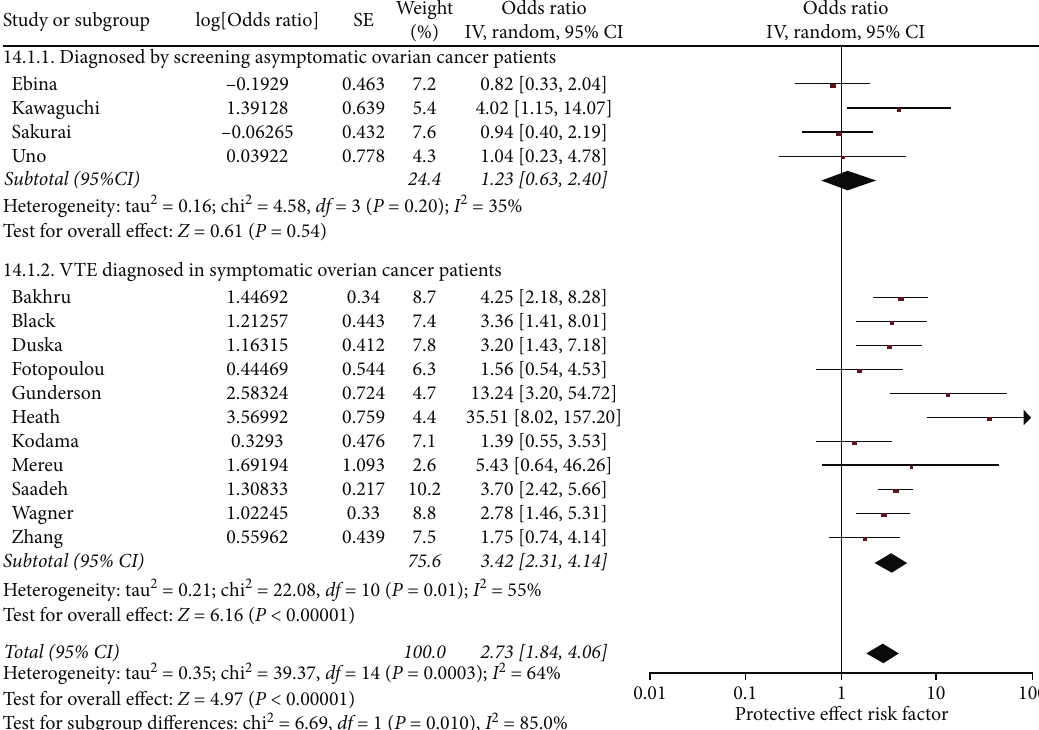
Figure 2: Forest plot of the odds of VTE in ovarian cancer patients that have cancer of stages III and IV at diagnosis (versus stages I and II). This figure shows the pooled odd of stage III/IV cancer (versus stage I/II). The total pooled odds are 2.73